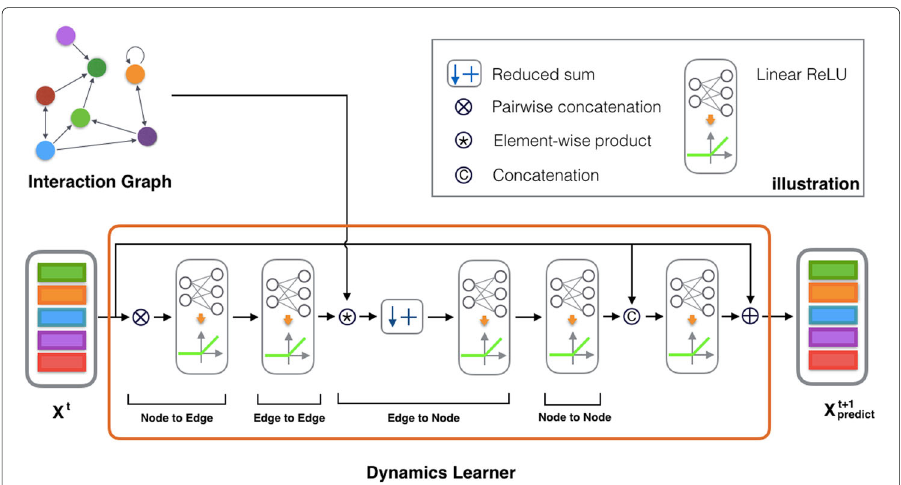
Fig. 2 The Structure of the Dynamics Learner. Dynamics Learner takes the graph structure (here we use Adjacency Matrix) and node states X as its input to predict node states at next time step(s). Four main parts operate in succession to accomplish the whole process: Node to Edge, Edge to Edge, Edge to Node and Node to